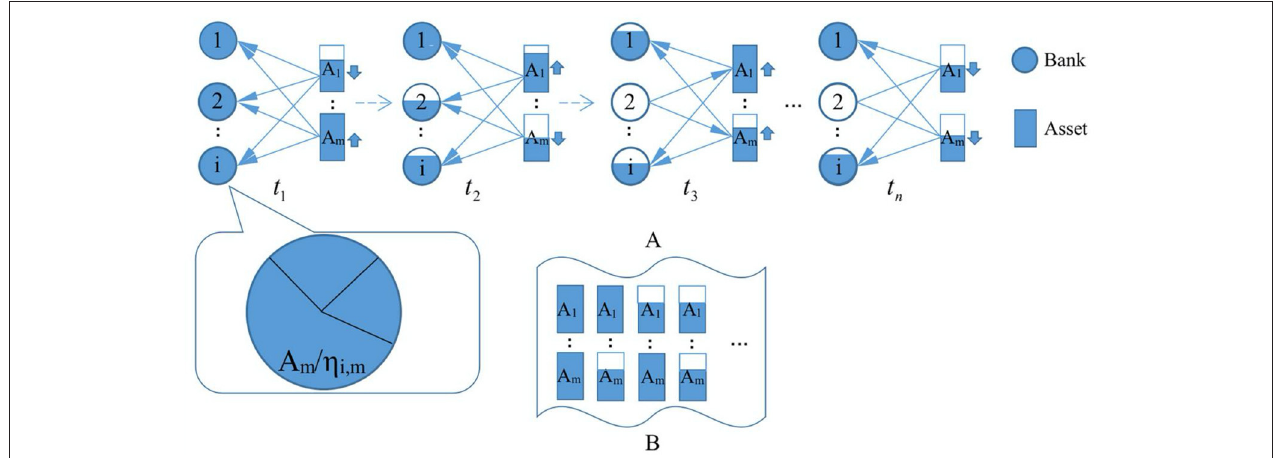
FIGURE 2 | Bank’s portfolio strategy model. (A) Represents all asset classes are simultaneously shocked at each time step. (B) Examples of all possible shock events.